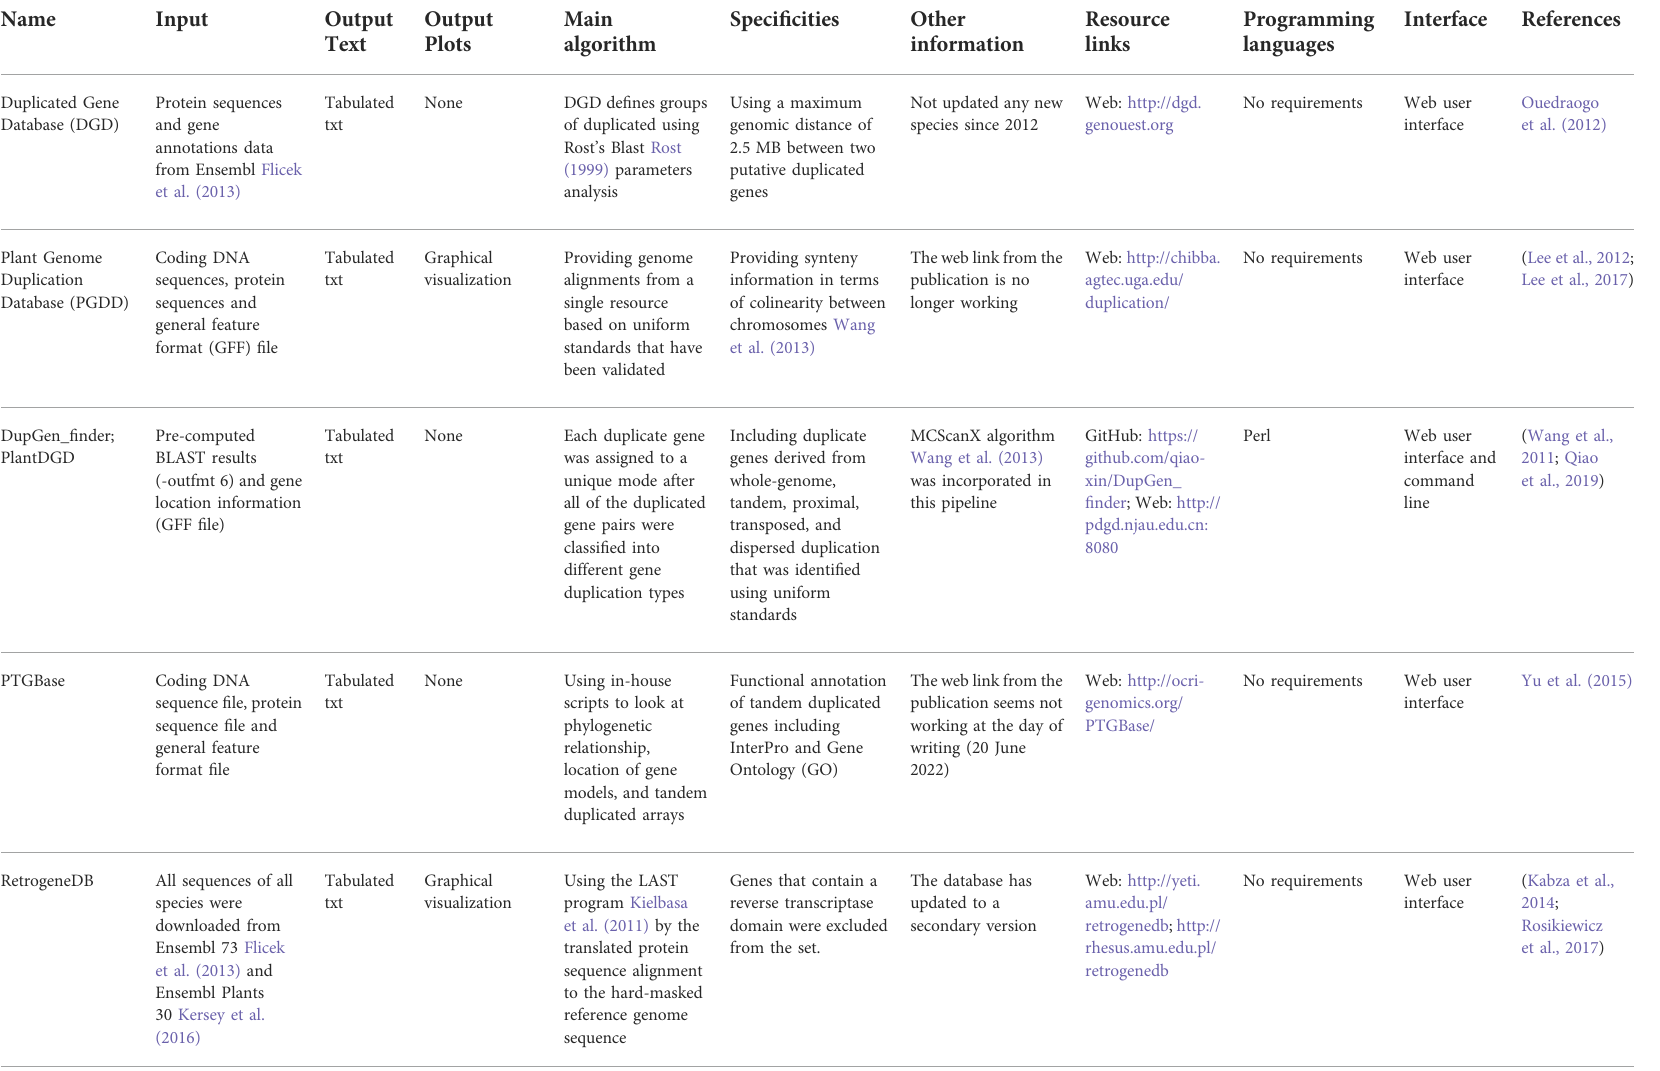
TABLE 2 Summary of the characteristics of different existing tools for identifying gene